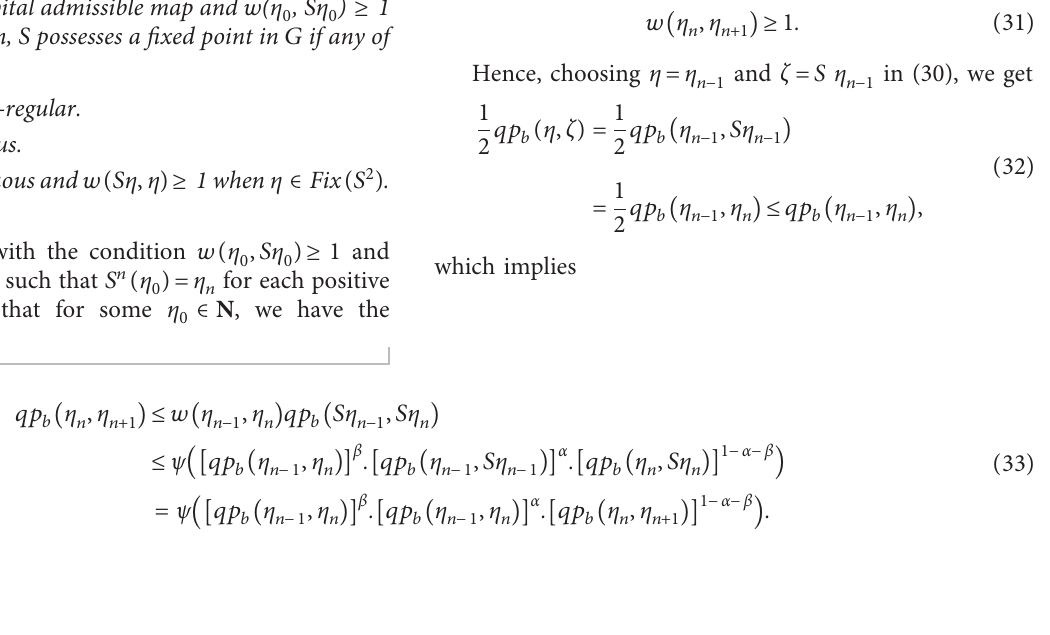
( η , ζ ) � Sin η + Sin ζ . Clearly, the fixed point of the map S is π b